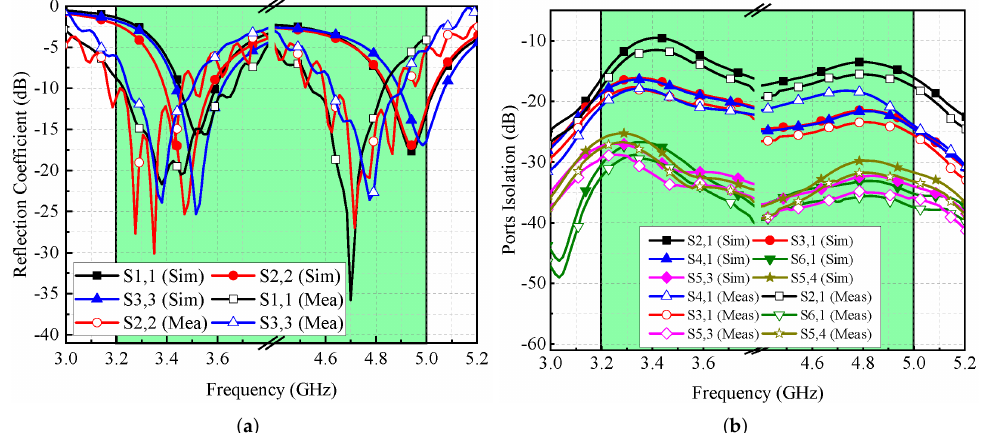
Figure 8. Simulated and measured scattering parameters of MIMO antenna ( a ) reflection coefficient and ( b ) isolation.